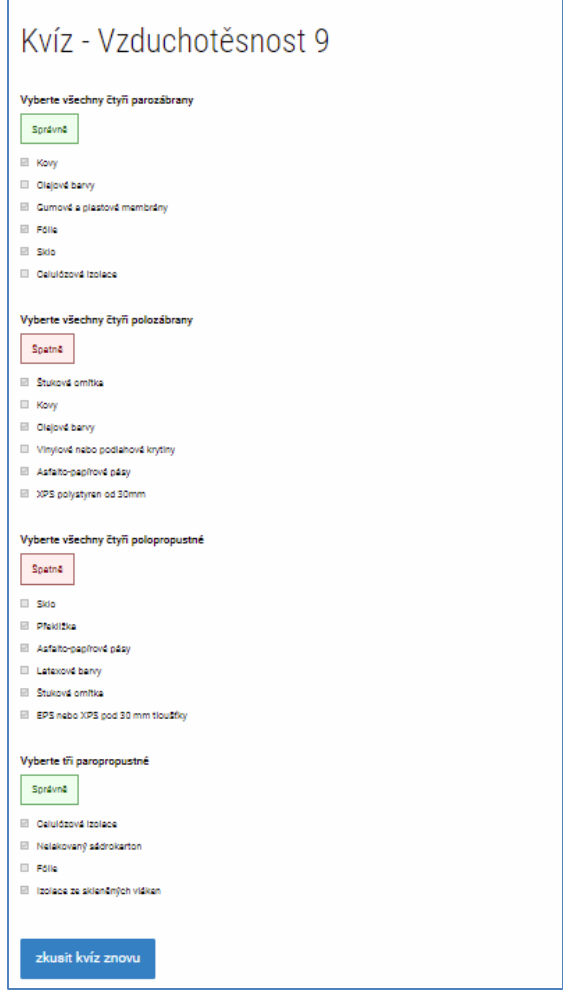
Figure 5: Selected page of e-learning - one of the Quizzes – for the Czech variant (source: